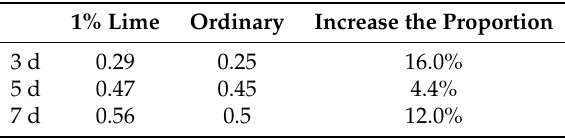
Table 12. Intensity values of the room temperature regimen on day 3, day 5, and day 7. 1% Lime